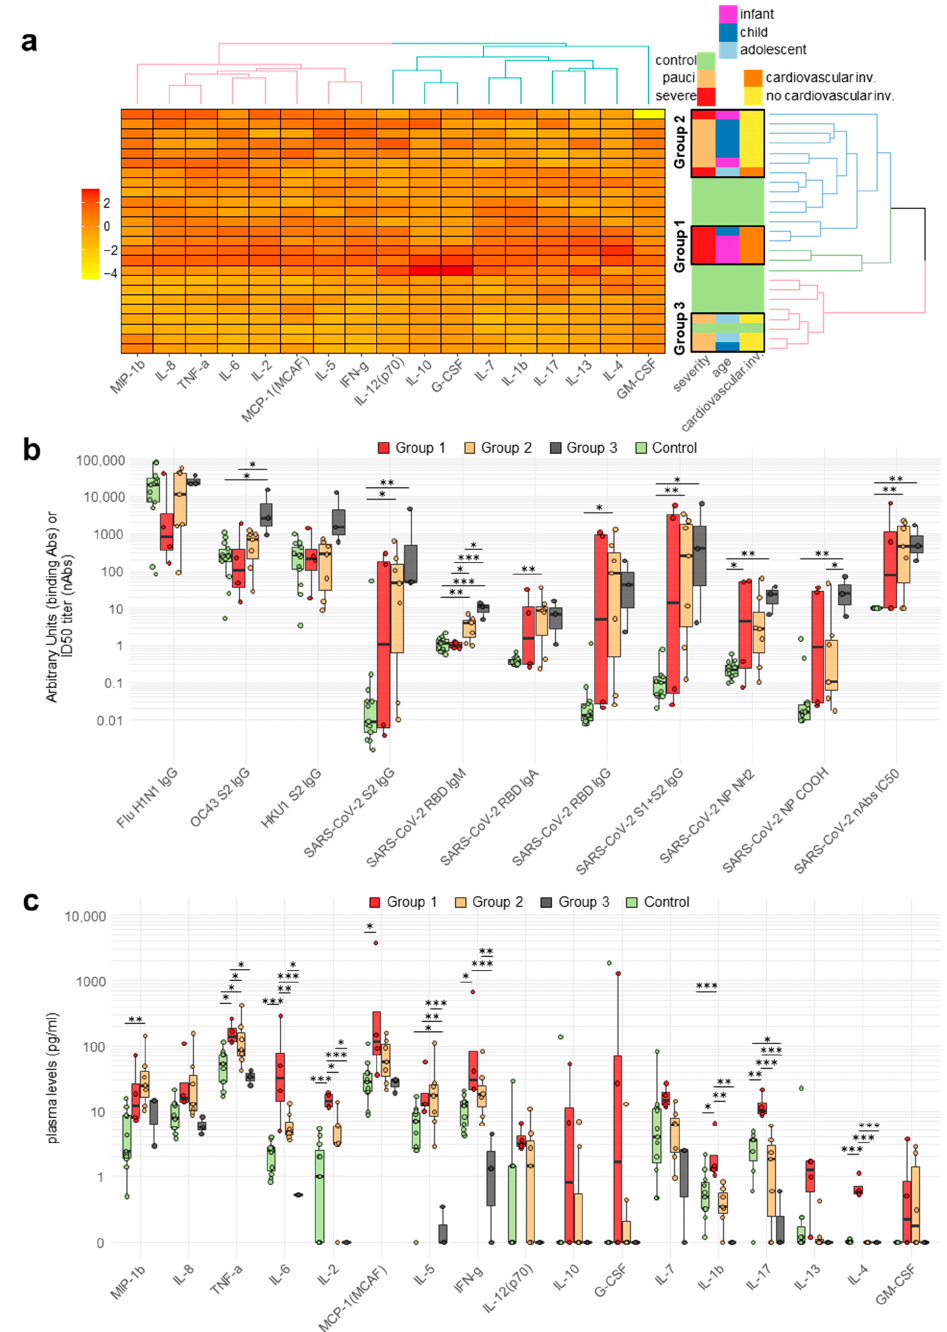
Figure 2. Plasma cytokine/chemokine levels in pediatric COVID-19 patients. (Panel ( a )): Heatmap of cytokine/chemokine levels in study subjects expressed using linear regression upon log trans- formation of the data and clustering (right panel) of the patients according to cytokine/chemokine plasma levels. (Panel ( b )): Antibody levels in patient groups derived from the clustering in (panel ( a )). Panel ( c ): Cytokine/chemokine plasma levels in patient groups derived from the clustering in (panel ( a )). In (panel ( b , c )), circles correspond to each subject’s antibody levels or cytokine/chemokine plasma concentration. Value distributions are summarized as boxplots showing the median and interquartile range with whiskers extending to ± 1.96-fold the median. Significant differences between groups are indicated by asterisks (ANOVA post hoc Tukey HSD test, p values adjusted for multiple comparisons, *** p < 0.001, ** p < 0.01, * p <